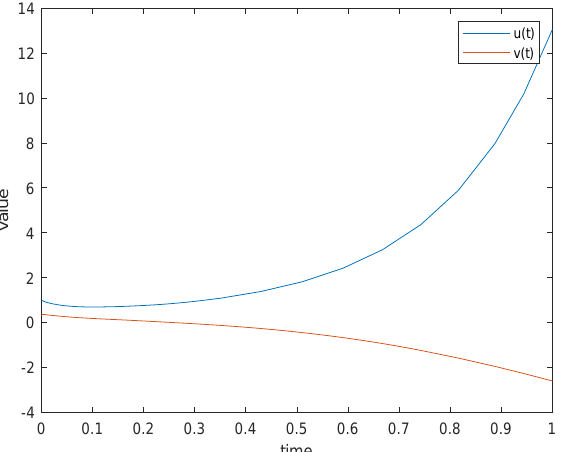
Figure 1. Numerical simulation of solutions of Example